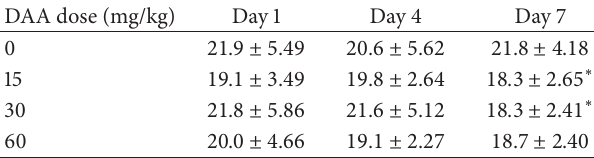
Table 2: Mean ( ± standard deviation) feed intake (g) per animal. DAA dose (mg/kg)